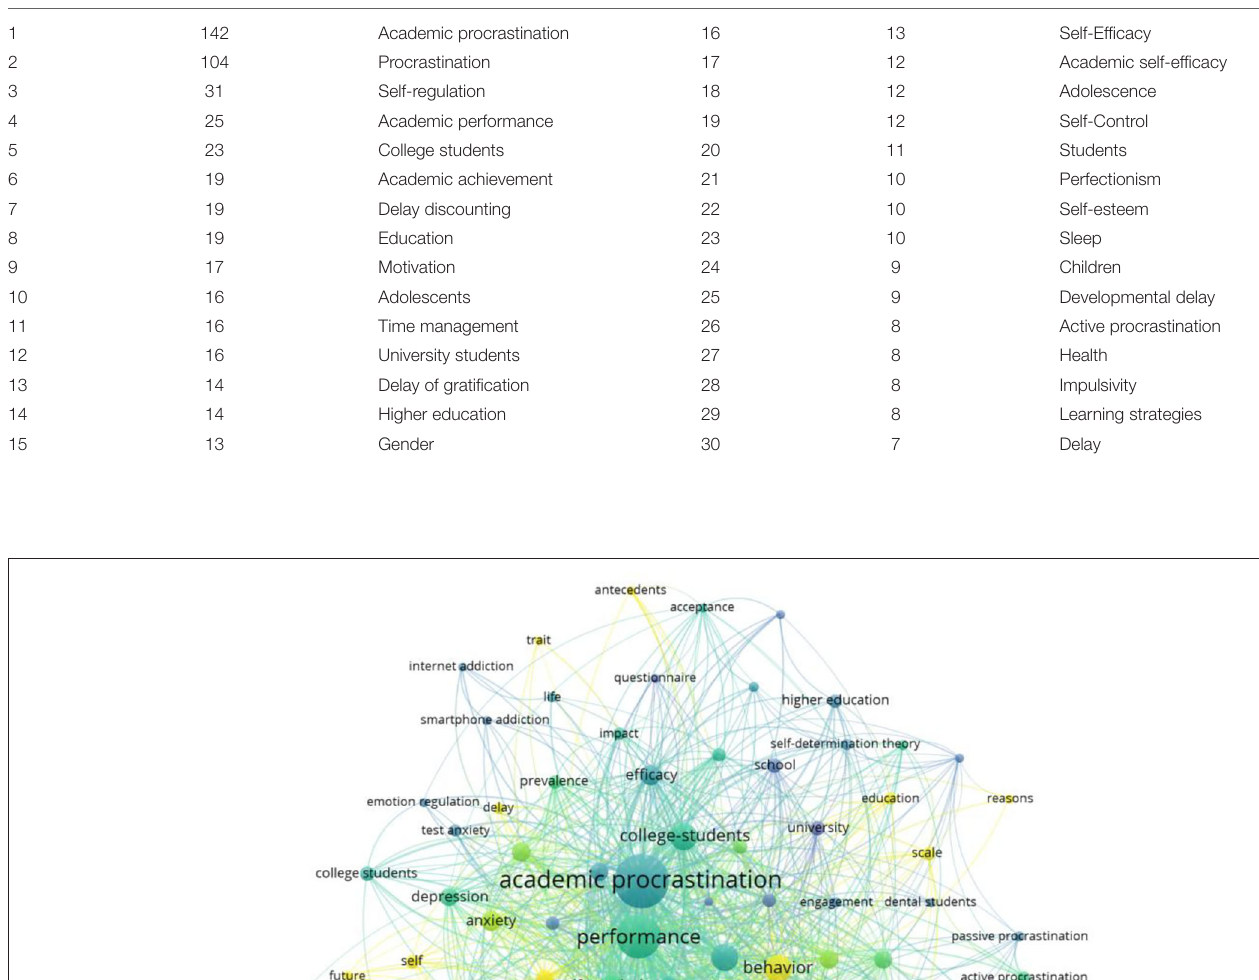
TABLE 8 | Top 30 keywords of academic procrastination research based on the frequency. Rank